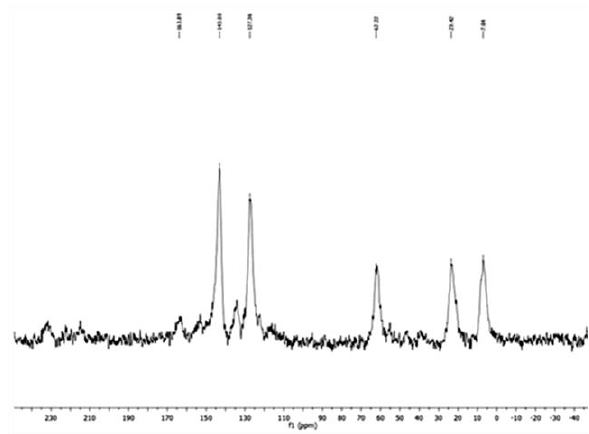
Figure 2. 29 Si CP/MAS nuclear magnetic resonance (NMR) spectrum of the pyridine periodic mesoporous organosilica (PMO-Py).